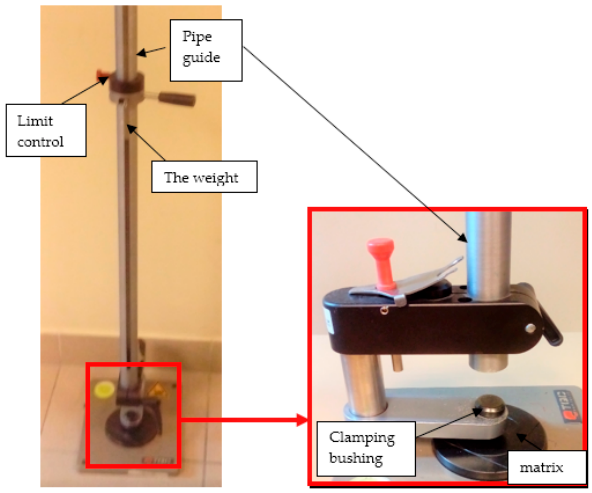
Figure 5. The test stands for evaluation of samples’ impact resistance—general view and the magnification of the base of the test stand.